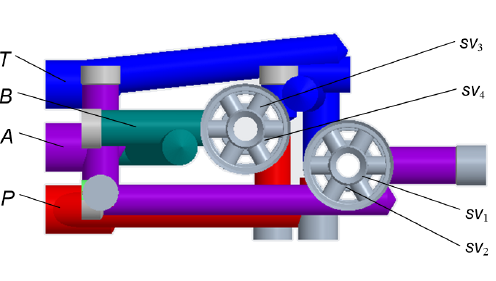
Figure 6. Fluid model (side view); P —supply channel, A , B —flow lines, T —return channel; sv 1 . . . sv 4 —seat